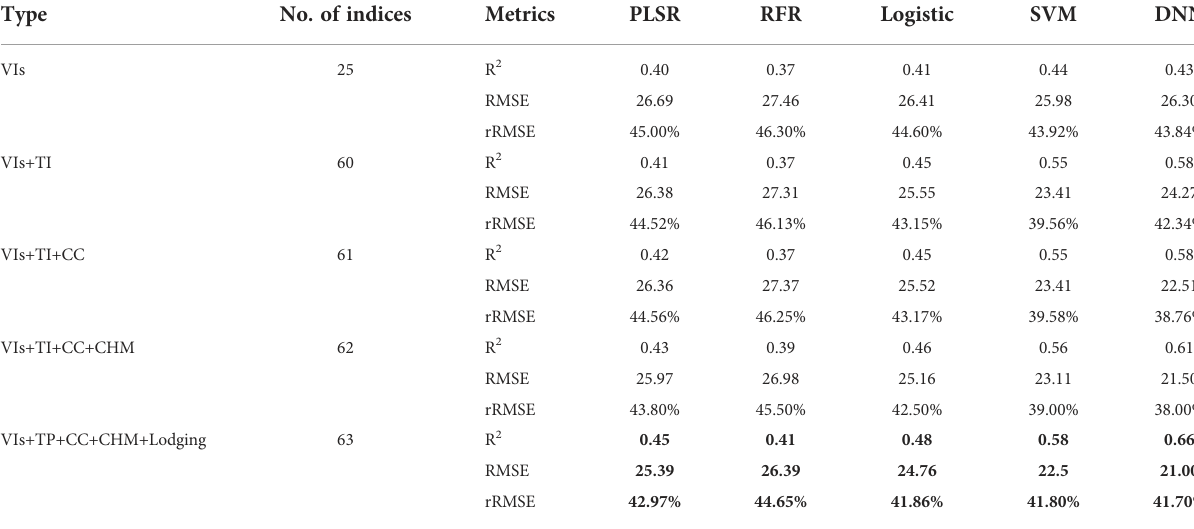
TABLE 3 The accuracy of estimation of different models for the grain number of seeds per plant.